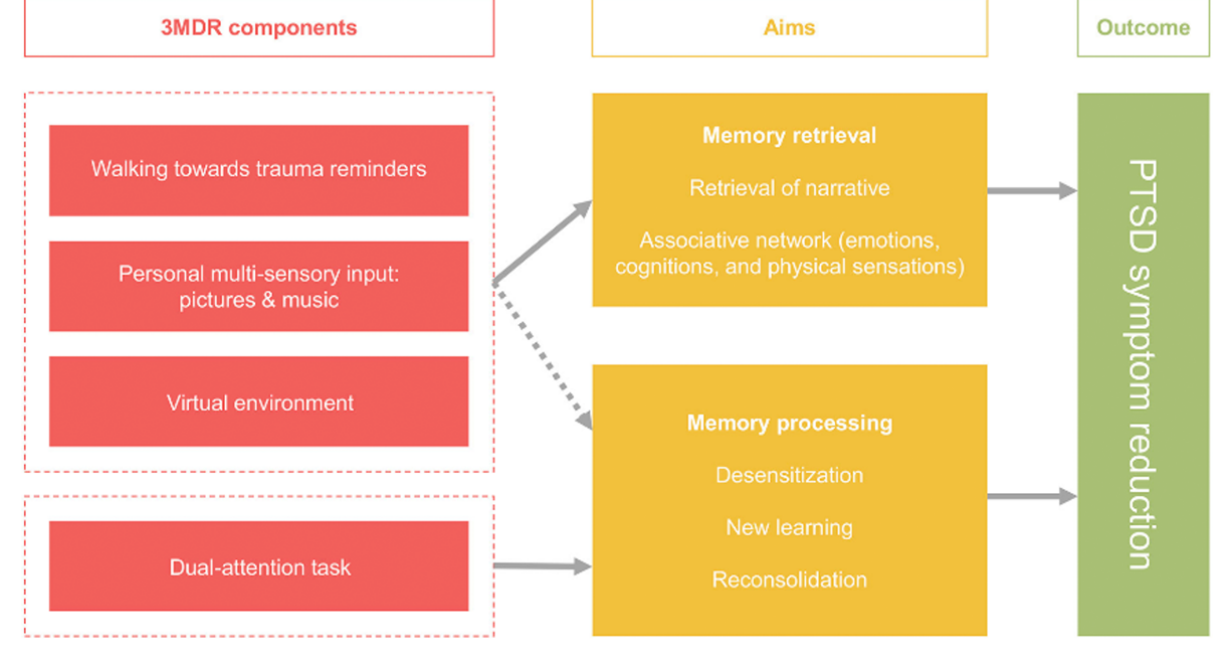
Figure 1. Schematic overview of the augmentation strategies applied in the framework of the multimodular motion-assisted memory desensitization and reconsolidation (3MDR) intervention and its outcomes. Used with permission [25]. PTSD: posttraumatic stress